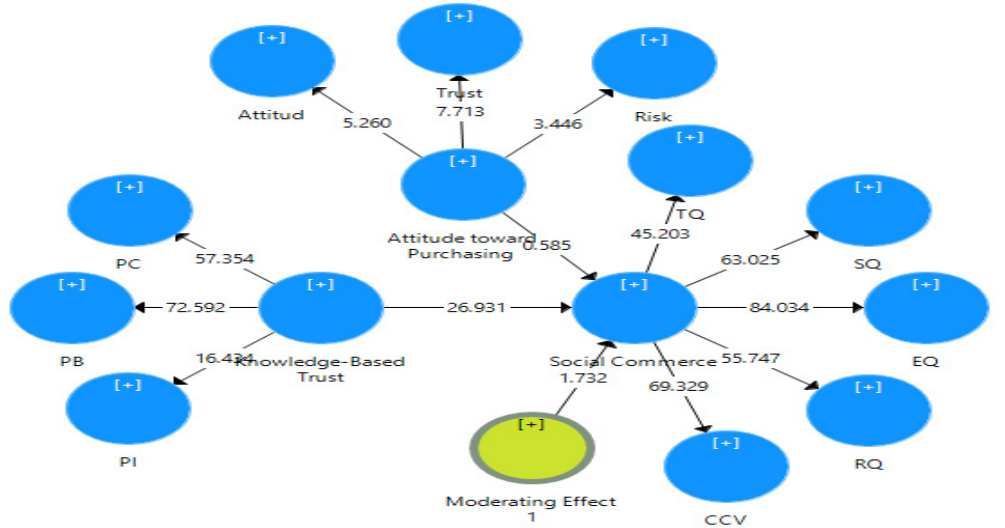
Fig. 3: Structural model in the meaningful mode